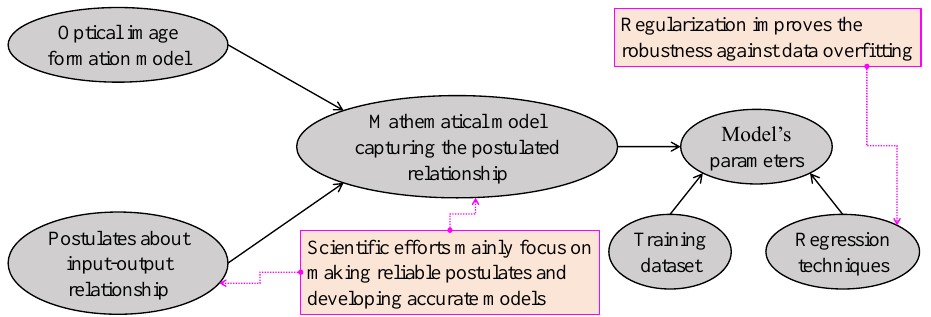
Figure 9. Simplified block diagram summarizing regression and regularization-based visibility restoration